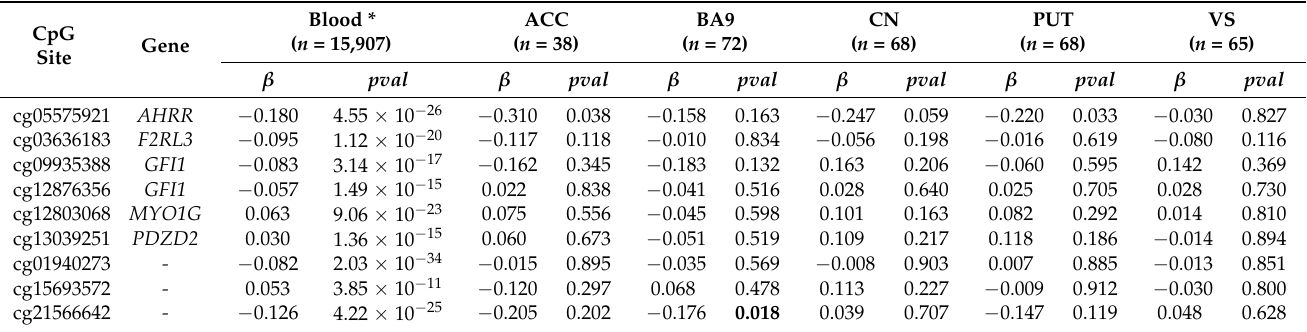
Table 3. Associations of the predictor CpG sites in blood and brain.